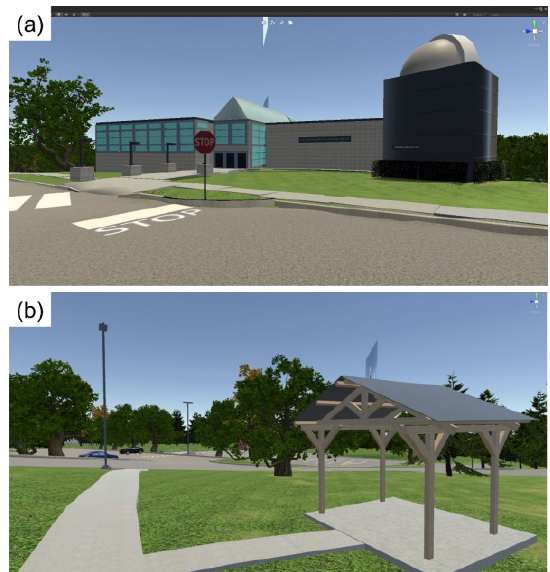
Figure 3. Virtual reality environment examples (a) front view of the Bell Center for Technology building (b) smoking area located at the side of the Bell Center for Technology